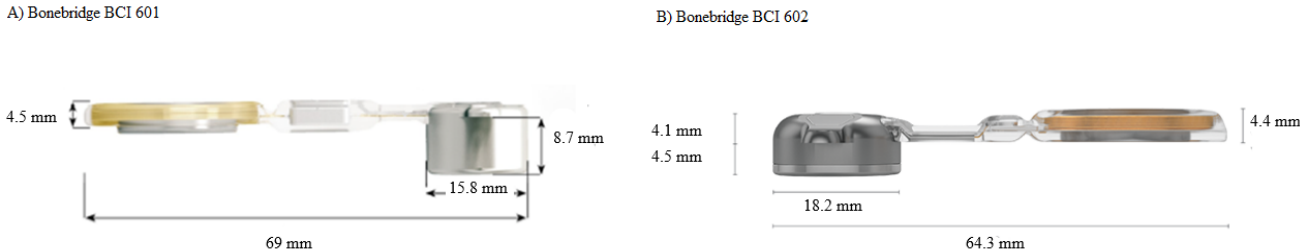
Figure 2. Bonebridge implants; ( A )—First-generation (BCI 601); ( B )—Second-generation (BCI 602) [21]. The most significant difference between the two models is the shape and size of the internal part, where the thickness of the BC-FMT has narrowed from 8.7 to 4.5 mm (Figure 3).